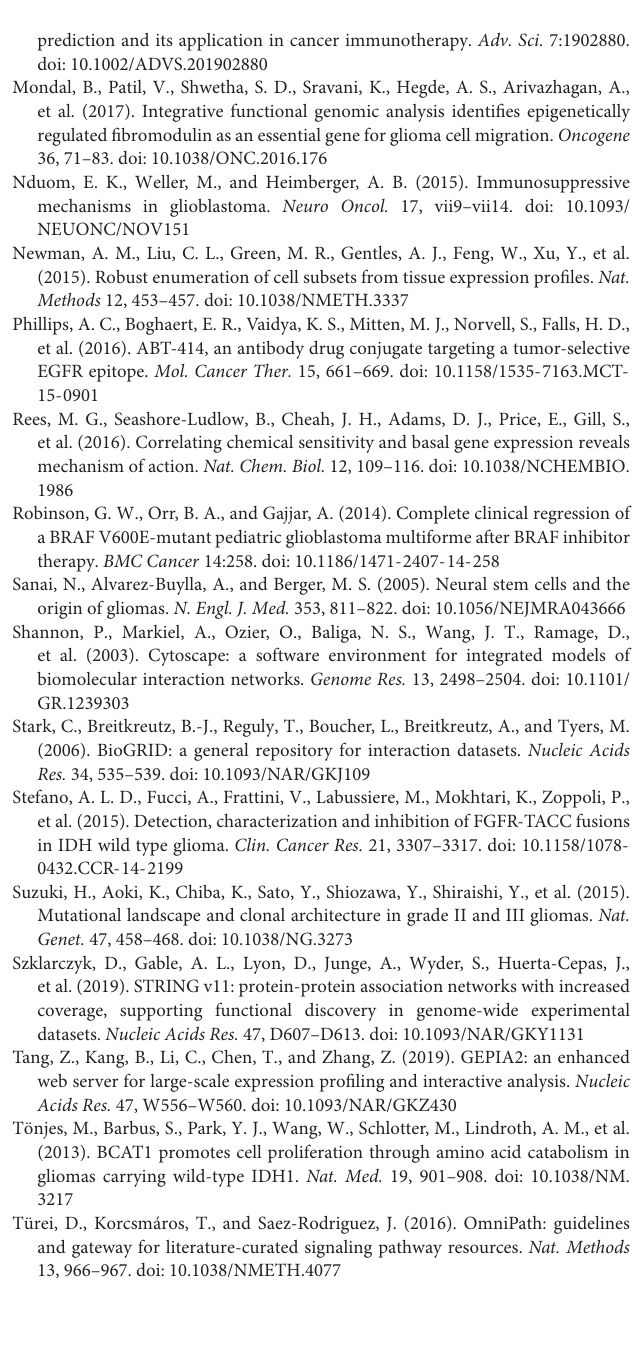
Supplementary Figure 1 | (A) Expression levels of model genes between tumor and normal tissues. (B) Survival map for OS, DSS, PFS, and disease free interval (DFI) with hazard ratios and cox p -values. (C) Kaplan–Meier survival curves of model genes. Supplementary Figure 2 | (A,B) Correlations between drug sensitivity and model gene expression in the CTRP and GDSC databases. (C,D) Networks of enrichment terms based on similarity with best p-values. Supplementary Figure 3 | Mutational profile of model genes. (A) Oncoprint mutation status, (B) lollipop charts, and (C) copy number variations of model genes. (D) Distinction of molecular features between mutant and wild-type groups ( p <